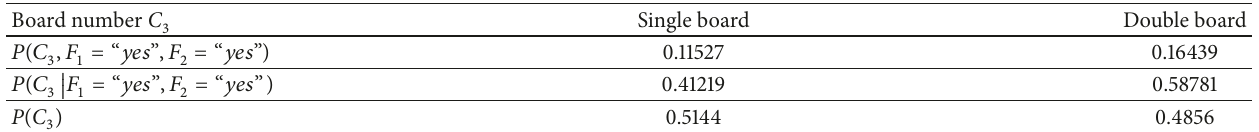
Table 7: The inference conclusions of C 3